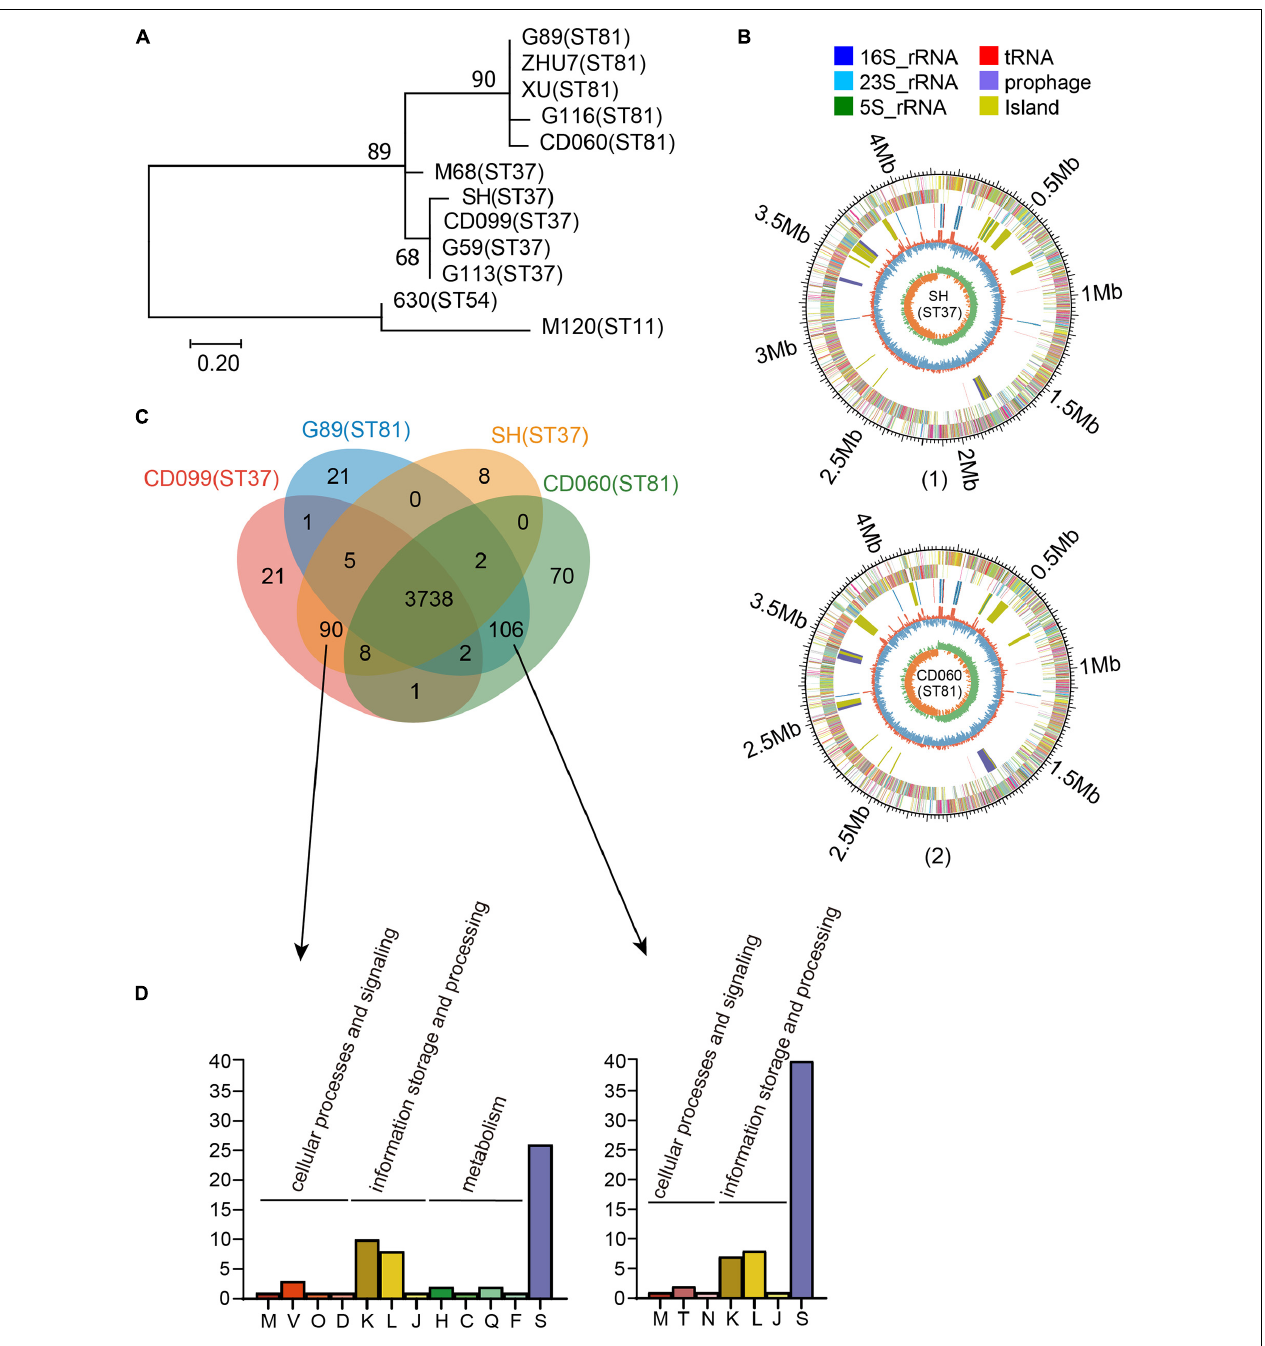
FIGURE 1 | Phylogenetic analysis and genomic features of the ST81 and ST37 isolates. (A) Analysis of phylogenetic tree depicting the relationships of C. difficile isolates based on SNPs by draft genome sequencing. CD630, CDM68, and CDM120 were used as reference strains. The sequence types are labeled in parentheses. (B) Schematic diagram of the complete genomes of C. difficile for isolate SH as a representative of ST37 (1) and for isolate CD060 as a representative of ST81 (2). The circle diagram indicated as follows (from the outer layer inward): the genome size, the annotated COG genes on the forward strand, the annotated COG genes on the reverse strand, 16S rRNA (dark blue), 23S rRNA (pale blue), 5S rRNA (green), tRNA (red), prophage (purple), island (yellow), GC content, and GC skew (G − C/G+C). (C) Venn diagram showing the number of shared and unique genes for the ST81 and ST37 isolates. (D) Enrichment of COG annotation of unique genes in ST37 (left) and ST81 (right). The classes are as follows: [M] cell wall/membrane/envelope biogenesis; [V] defense mechanisms; [O] post-translational modification, protein turnover, chaperones; [D] cell cycle control, cell division, chromosome partitioning; [K] transcription; [L] replication, recombination, and repair; [J] translation, ribosomal structure, and biogenesis; [H] coenzyme transport and metabolism; [C] energy production and conversion; [Q] secondary metabolites biosynthesis, transport, and catabolism; [F] nucleotide transport and metabolism; [S] function unknown; [T] signal transduction mechanisms; [N] cell motility.